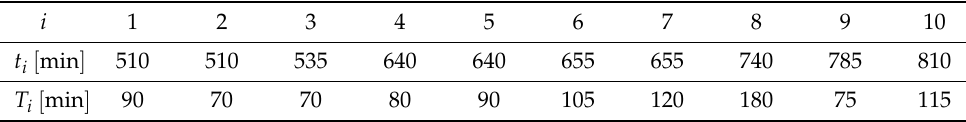
Table 6. Input values of constants t i and T i for flights 1–10.